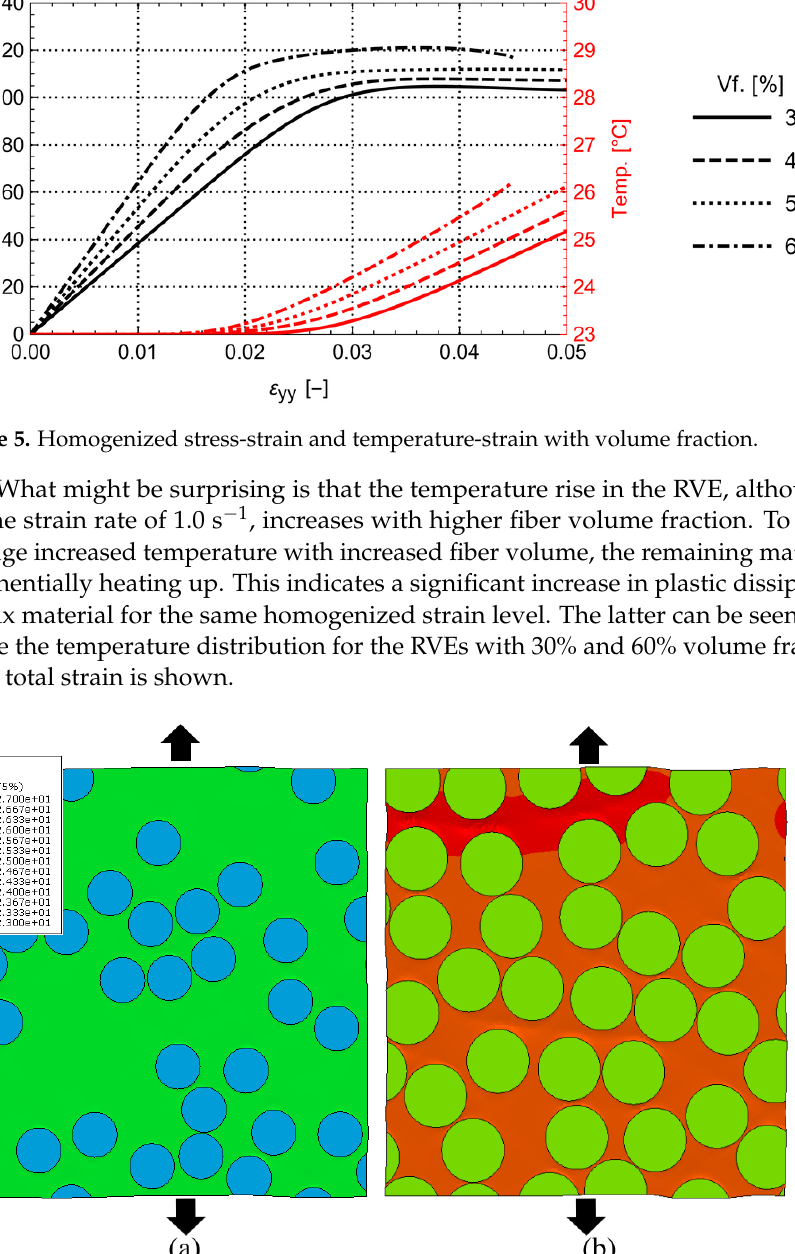
Figure 6. Temperature distribution for the RVEs with Vf. = 30% ( a ) and 60% ( b ) at a ε = 0.043 and ε . ̇ = 1 s −1 ε = 1 s − 1 and